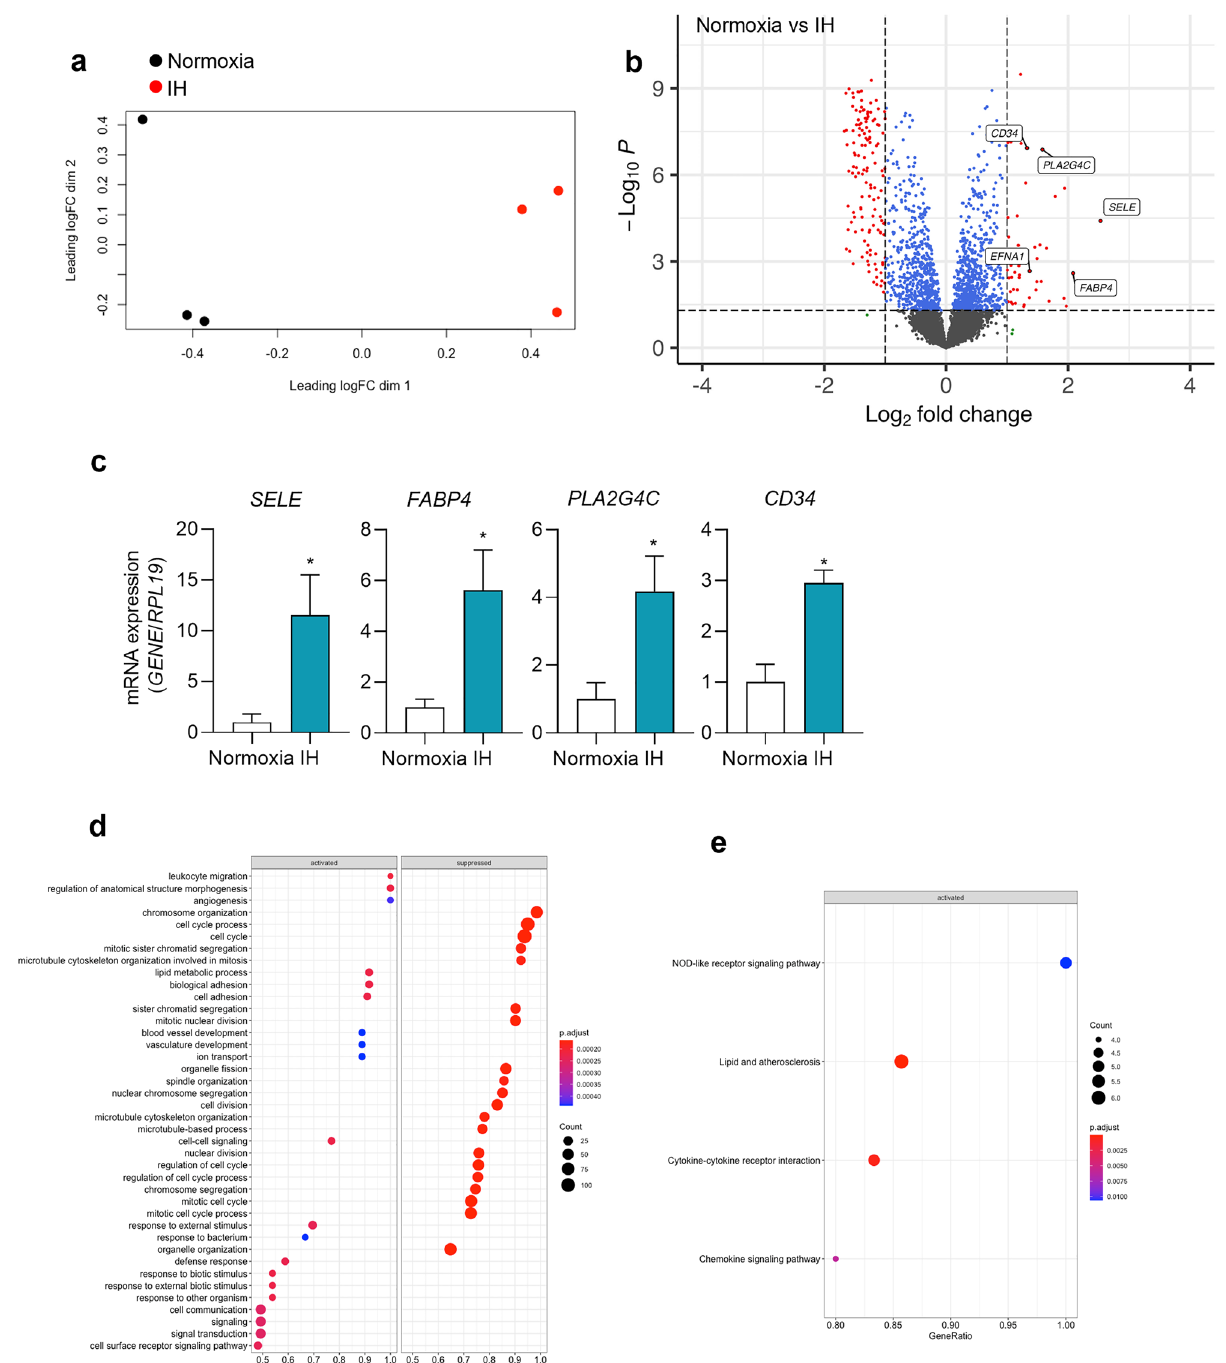
Figure 1. Transcriptional changes in human aortic endothelial cells after exposure to intermittent hypoxia. Human Aortic Endothelial Cells (HAECs) were exposed to 60 cycles of IH (5%-20% O 2 ) or normoxia (20% O 2 ) (control). RNA-sequencing was performed from RNA isolated from 3 biological replicates. ( a ) Multidimensional scaling plot of differentially expressed genes in HAECs under IH compared to control normoxia. LogFC dim 1, and dim 2: base 2 logarithm of fold change dimension 1 and 2. ( b ) Volcano plot of -Log10 ( p values) vs. Log2 fold change for DEGs and top significantly upregulated genes in IH. The -log10 ( p values) represents the level of significance of each gene while log2 fold change represents the difference between the levels of expression for each gene. ( c ) Using qPCR, we measured mRNA expression of E-selectin ( SELE ), Fatty acid binding protein 4 ( FABP4 ), Cytosolic phospholipase A2 gamma ( PLA2G4C ), and Hematopoietic progenitor cell antigen CD34 ( CD34 ) in HAECs under control normoxia and IH (data are shown as mean ± SD, n = 6, biologic replicates). * p < 0.05. Parameters for DEG significance were set to absolute fold change ≥ 2 and FDR adjusted p value ≤ 0.05. Activated and suppressed ( d ) gene ontology biological processes (GO BP) and ( e ) activated KEGG pathways were identified by gene set enrichment analysis of DEGs in HAECs under IH compared to normoxia. The raw source data for RNA-seq are accessible via GEO (GSE205050). https:// www. ncbi. nlm. nih. gov/ geo/ query/ acc. cgi? acc= GSE20